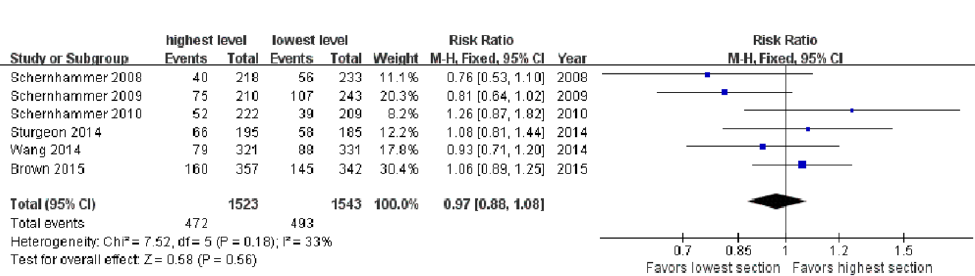
Figure 2. Forest plot for the association between urinary 6-sulfatoxymelatonin levels and breast cancer risk. Case subjects are defined as women who developed breast cancer after their enrollment in the study cohort, and matched healthy control subjects are randomly chosen, alive, and free of cancer at the time of diagnosis of the index case subject. Events indicate cases in the highest proportion or in the lowest proportion. Urinary 6-sulfatoxymelatonin levels are not significantly associated with overall breast cancer